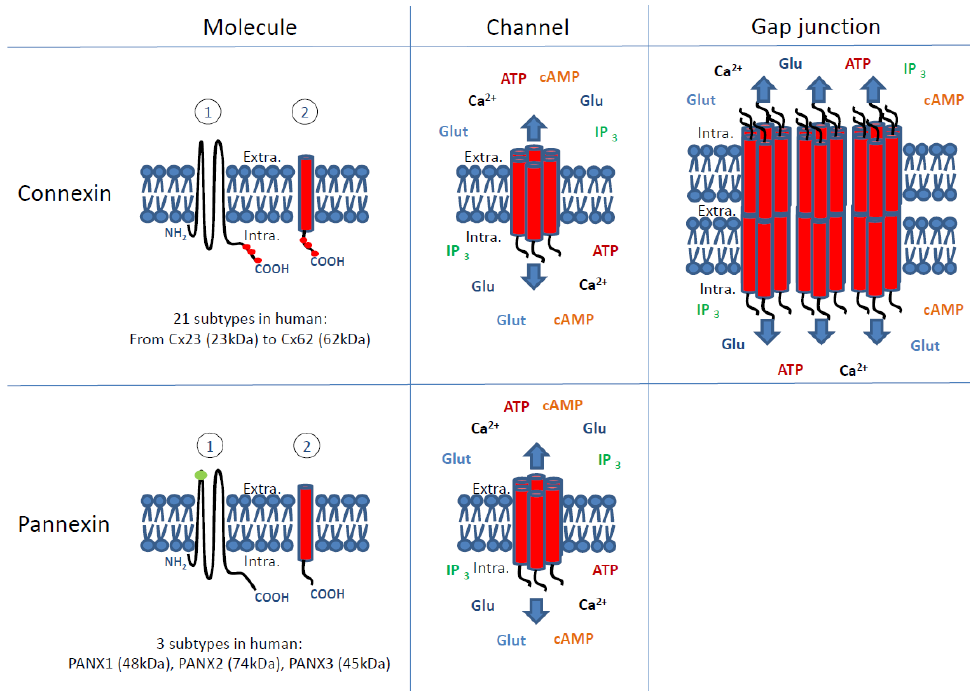
Figure 1. Connexin and pannexin molecules and channels formed by these molecules. As molecules, connexins (Cx) and pannexins (Panx) have similar topology with four transmembrane and intracellular (Intra.) NH 2 and COOH domains. In the left panels, both kinds of molecules are shown in a “spread” way to distinguish their topology (1) and in a “condensed” way (2) to better represent as transmembrane subunits of channels (centre panels) and gap junctions (right panel). In humans, 21 subtypes of connexins have been characterized, which are differentially expressed in tissues [8]. They are named according to their expected molecular weight (kDa) from the smallest connexin (Cx23: 23 kDa) to the largest one (Cx62: 62 kDa). The best-known member of the connexin family is the connexin43 (Cx43) which is the most common in the organism. Only 3 pannexin subtypes are known in human (PANX1, PANX2, PANX3) [9,10]. Except for Cx26, connexins can be phosphorylated mostly at their intracellular COOH tail (red spots) [11]. The level of phosphorylation potentially modifies channel gating, interaction with intracellular or other membrane proteins (connexin interactome) and thus their function and life cycle [11,12]. So far, pannexins do not appear to be regulated by phosphorylation as connexins are but they are more characterized as potentially N-glycosylated (green spots) molecules at their extracellular (Extra.) domain. Both connexins and pannexins can aggregate to form hexameric transmembrane channels permitting the passive passage of ions (e.g., Ca 2+ ) and small (<1–1.5 kDa) hydrophilic molecules such as nutrients (e.g., glucose: Glu), amino acids (e.g., glutamate: Glut), nucleotides (e.g., ATP) and second messengers (e.g., cAMP and IP 3 ). Theoretically, connexin-made channels (connexons also called hemichannels) and pannexin-made channels (pannexons) are permeable to the same type of ions and molecules even if pannexons permeability has been mostly studied for ATP, Ca 2+ and glutamate (Glut). Moreover, connexons from one cell can dock with connexons of juxtaposed cells forming intercellular channels aggregated in gap junctions which permit the direct intercellular transfer from cytosol to cytosol (gap-junctional intercellular communication, GJIC) of same ions and molecules as isolated connexons. So far, no pannexon-made gap junctions have been described in physiological/pathological conditions. The term connexon is mostly used to define the transmembrane unit of gap junctions. When isolated in the plasma membrane, connexons are usually called hemichannels and can open with various stimuli such as, for example, hypoxia. For clarity in the figure, putative phosphorylation sites (red spots) and N-glycosylated sites (green spots) are not shown in channels and gap junctions.